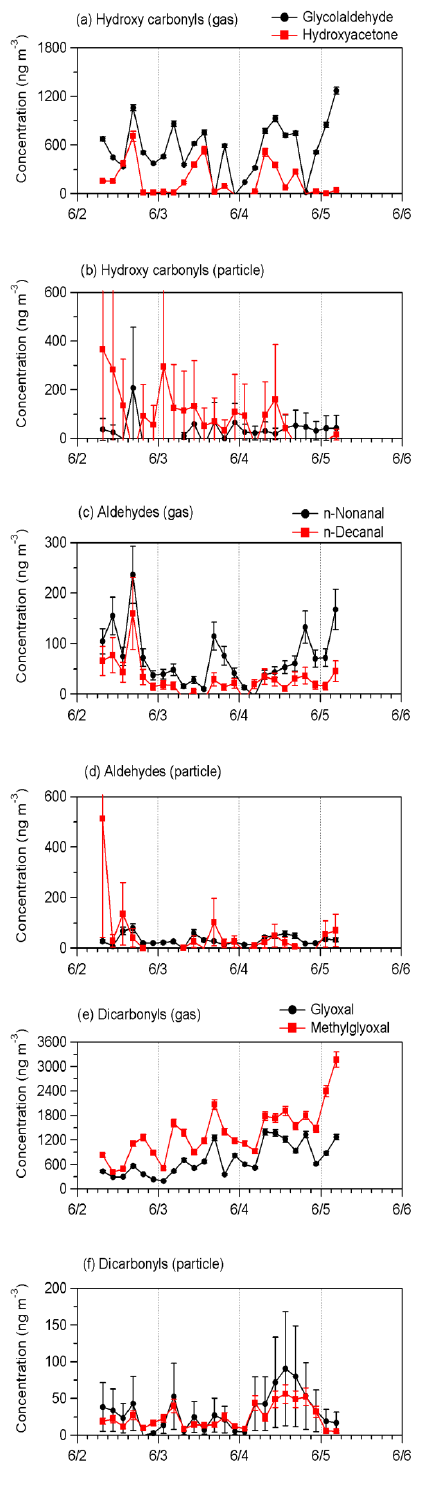
Fig. 6. Comparison of time-resolved variations for gaseous and par- ticulate carbonyls in the Mt. Tai atmosphere as three types of car- bonyls (hydroxy carbonyls, n-aldehydes and α -dicarbonyls).